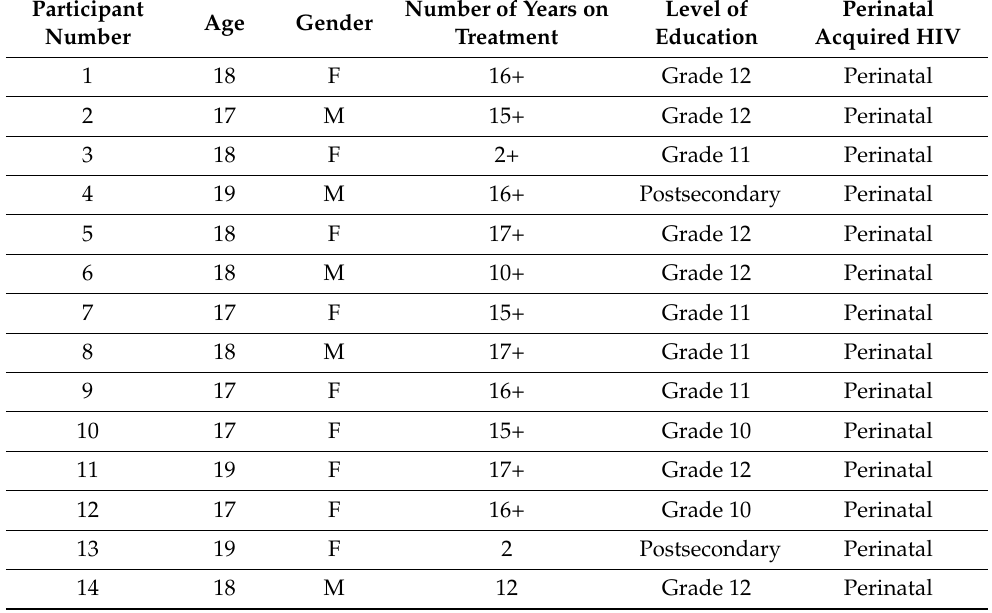
Table 1. Biographical information of the